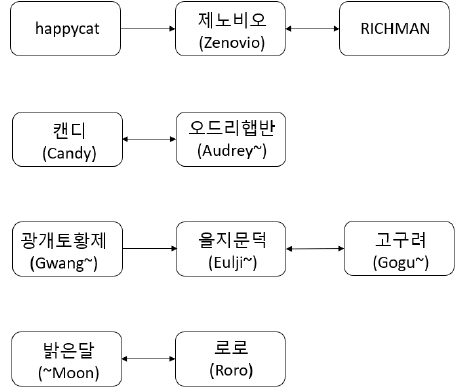
Figure 8. Groups who write similar comments.